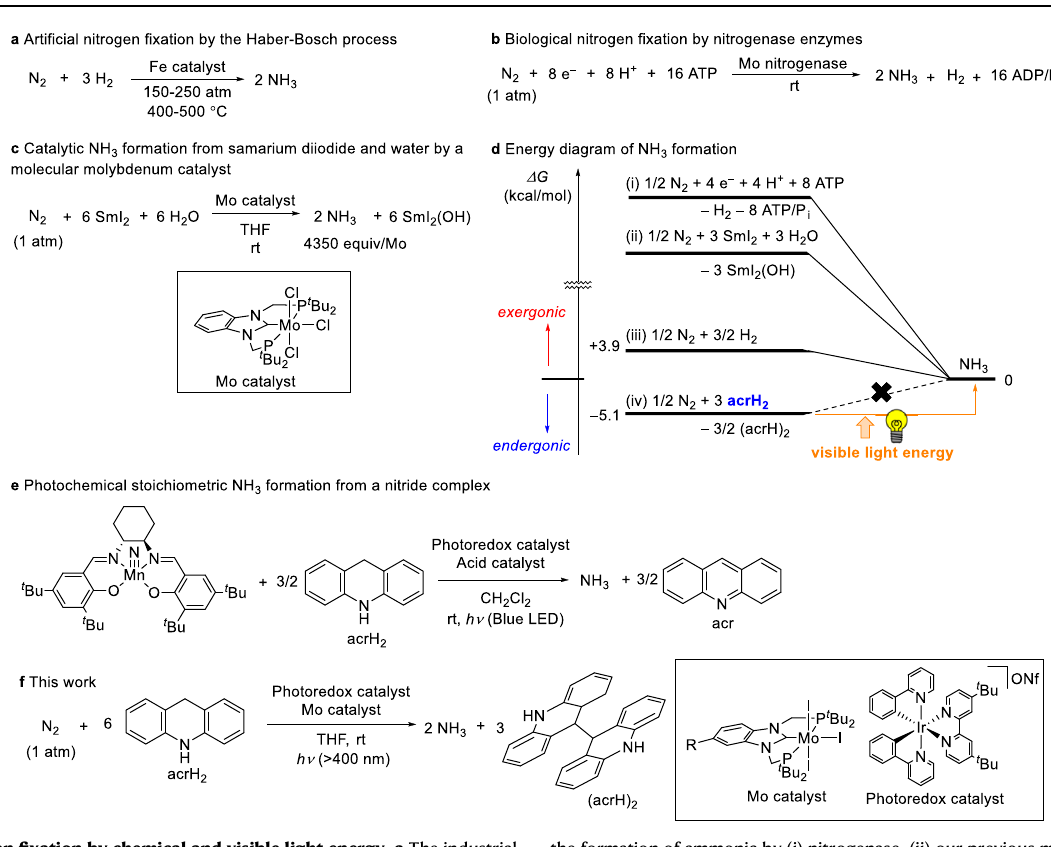
Fig. 1 | Nitrogen fi xation by chemical and visible light energy. a The industrial ammonia production from dinitrogen and dihydrogen by the Haber – Bosch pro- cess. b The biological reduction of dinitrogen into ammonia with a reductant, a proton source, and ATP by Mo nitrogenase. c Catalytic ammonia formation in the presence of the molybdenum complex using SmI 2 and water. d Energy pro fi les